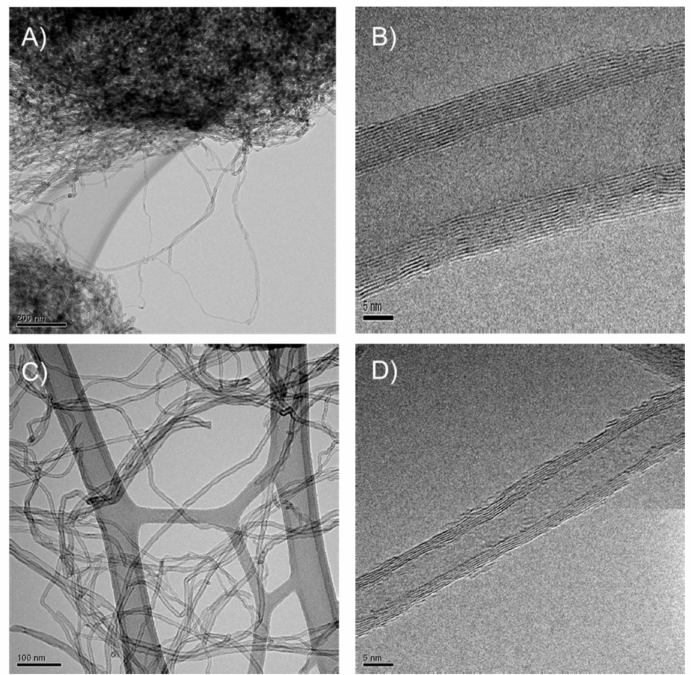
Figure 5. Micrographs of ( A , B ) CNTs and ( C , D ) CNT-SP adduct. Micrographs are: ( A , C ), low magnification bright field Transmission Electron Microscopy (TEM); ( B , D ) High-Resolution Transmission Electron Microscopy (HRTEM)